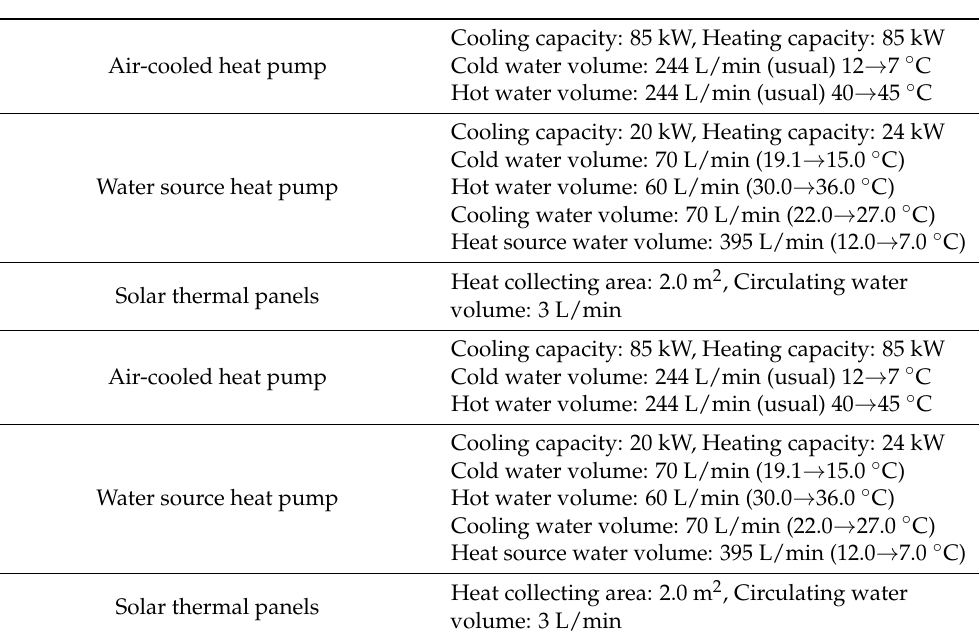
Table 3. Outline of the heat